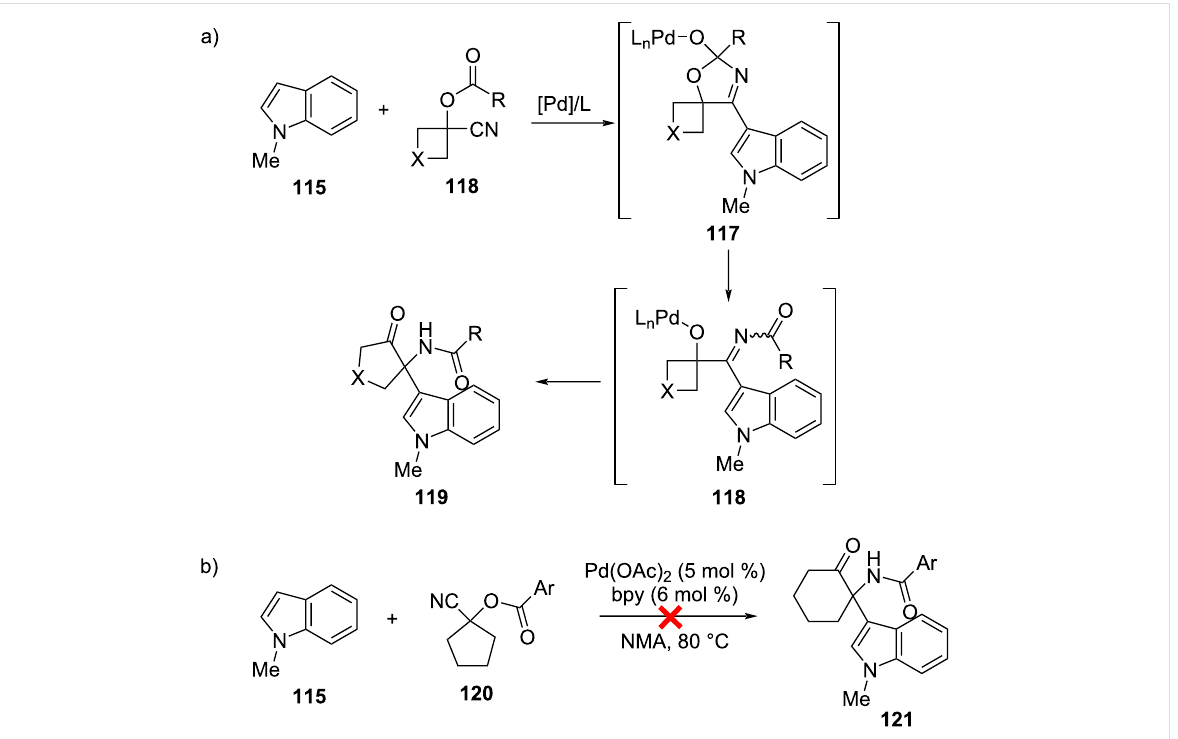
Figure 21: Tandem synthesis of functionalized α -amino cyclopentanones 119 from heteroarenes 115 and cyclobutanone-derived cyanohydrins 116 . a) Pd-catalyzed C–H addition of 115 to the nitrile group of 116 produces intermediates 117 and 118 . An α -iminol rearrangement with ring expansion subsequently produces 119 . b) Cyclopentanone-based substrates ( 120 ) do not react under the same